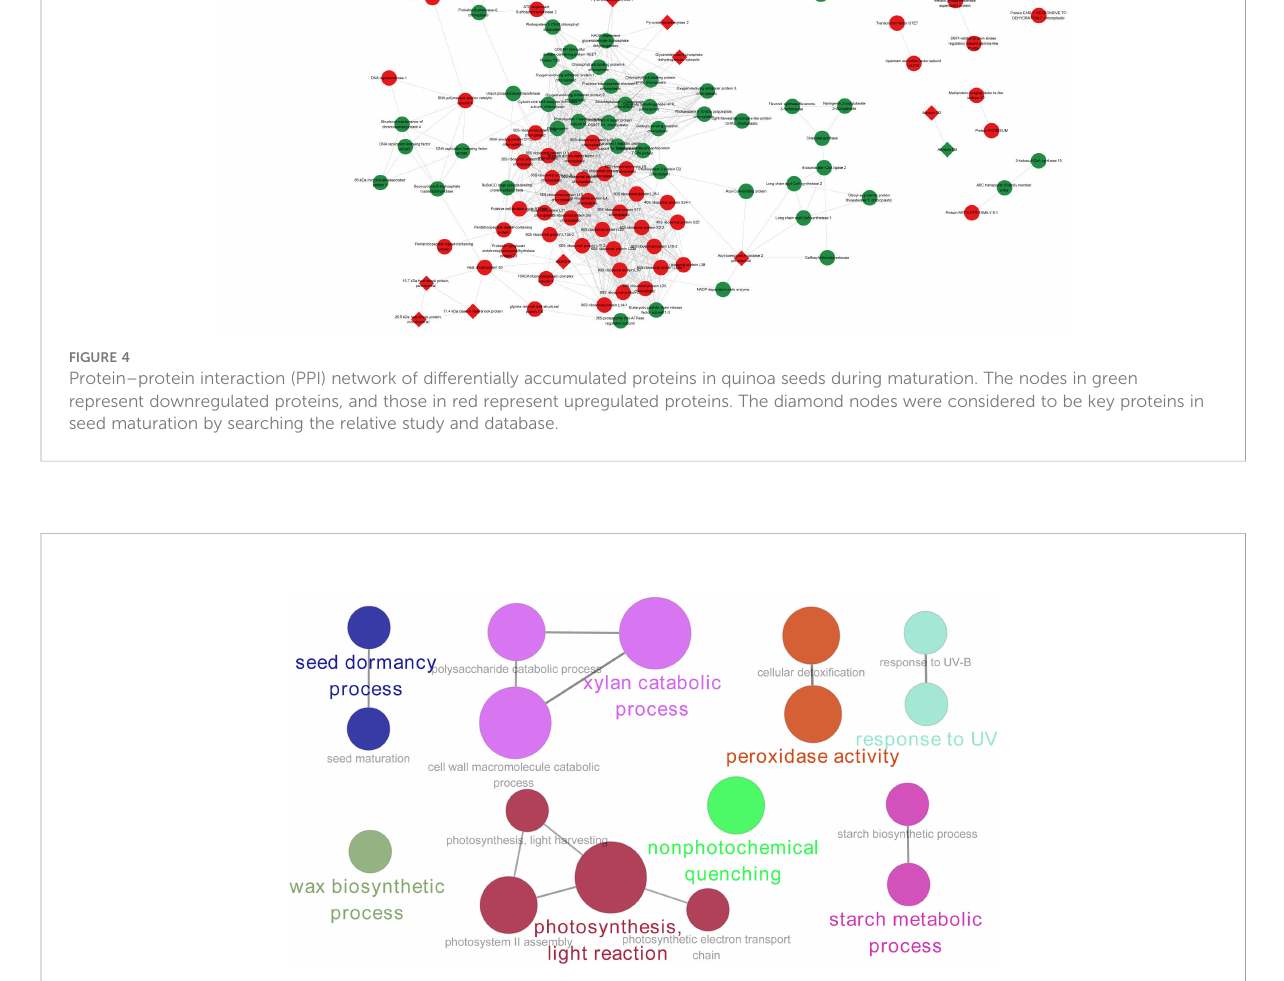
FIGURE 5 Gene Ontology (GO) enrichment (biological process) analysis of DAPs in quinoa during seed maturation. The size of the node represents the number of annotated proteins, and the color represents different GO terms ( p <